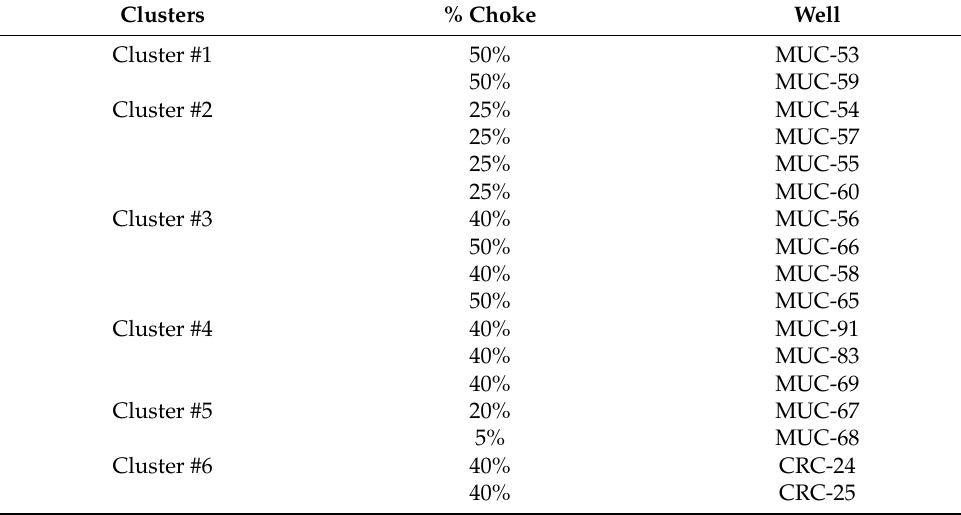
Figure 1. Diagram of the gas injection process in a cluster. The gas from the turbocompressor units enters the discharge manifold with an ap- proximate pressure of 527.30 kg/cm 2 , for the average injection of 1000 MMPCFD through the injection networks, which are distributed in six clusters that supply gas to seventeen gas injection wells. Next, Table 1 indicates how the wells are distributed with respect to the cluster, with their respective valve opening percentage per well (% choke). Table 1. Well